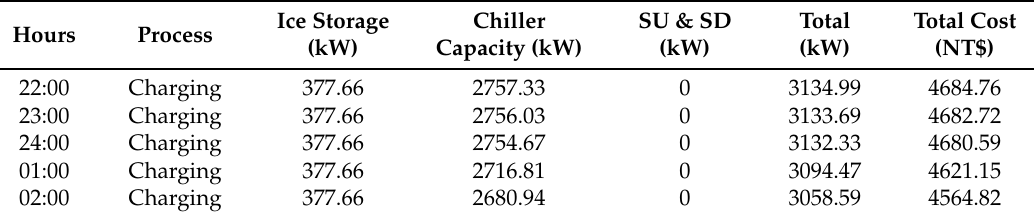
Table 7. Power loads of demand response for